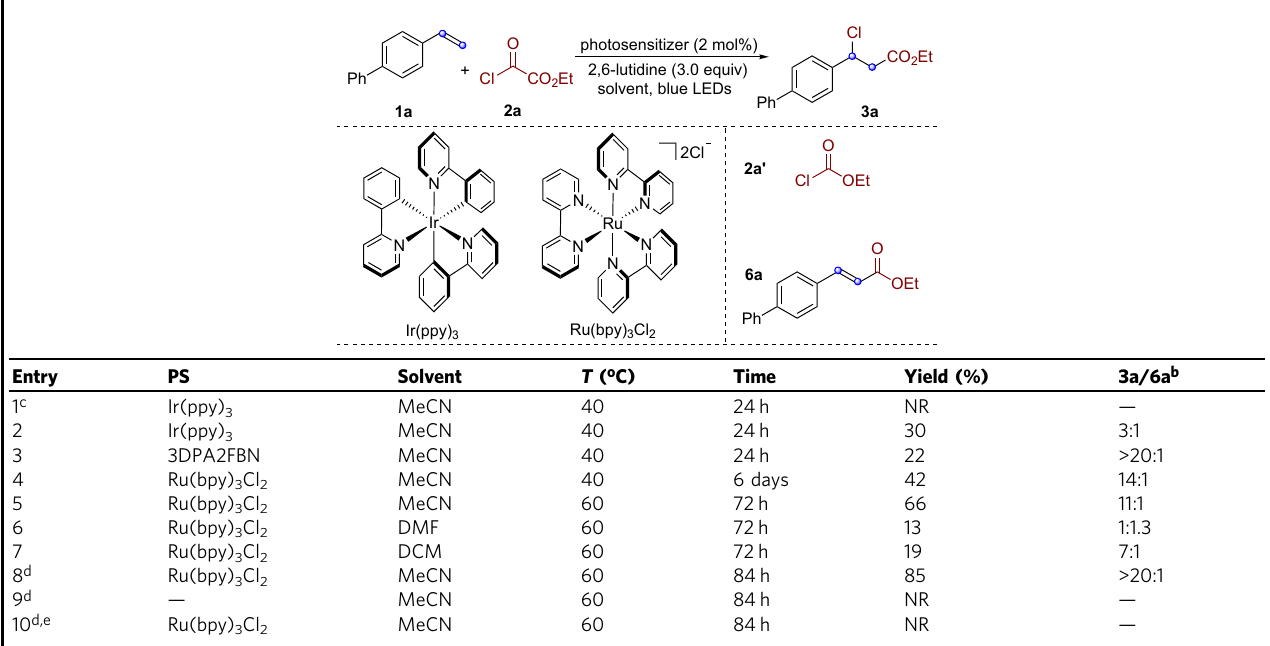
Table 1 Initial studies for the photoinduced reaction of 4-vinyl-1,1 ’ -biphenyl 1a with ethyl chlorooxoacetate 2a a